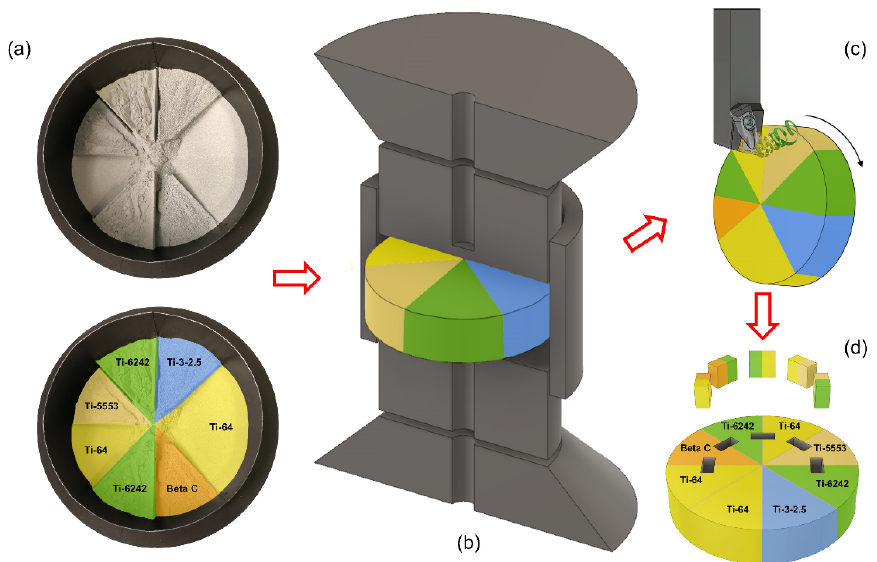
Figure 1. Schematic diagram of the methodology used in this research to understand the machinability of multi material components. ( a ) A photograph of five different powders distributed inside a graphite mould. ( b ) A 3D render of the cross section of the tooling used to process the powder into a solid Mul Ti ‐ FAST billet. ( c ) A 3D render of the machining stage performed on the Mul Ti ‐ FAST billets. ( d ) Graphic representation of the location where the material was sectioned and analysed.